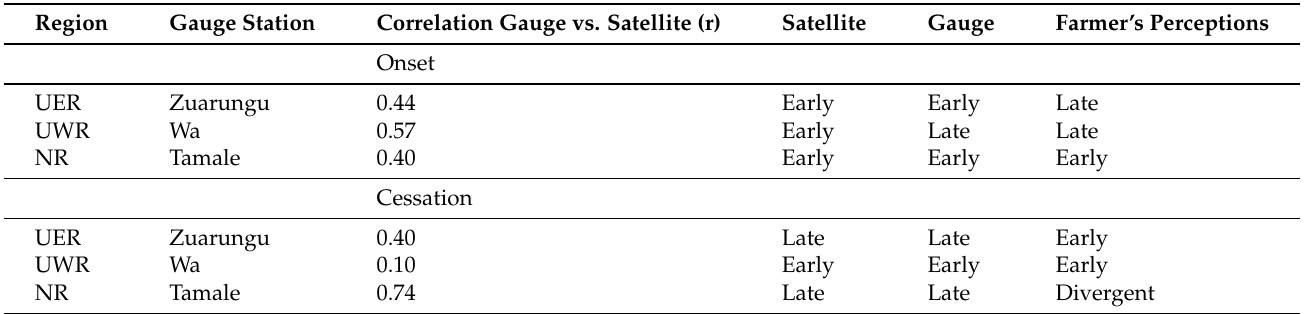
Table 2. Summary of the trends of onset and cessation dates of rainfall from the gauge and satellite at representative stations from Figure 5 and the aggregated farmer’s perceptions per region obtained from Figure 9a–c. Region Gauge Station Correlation Gauge vs. Satellite (r) Satellite Gauge Farmer’s